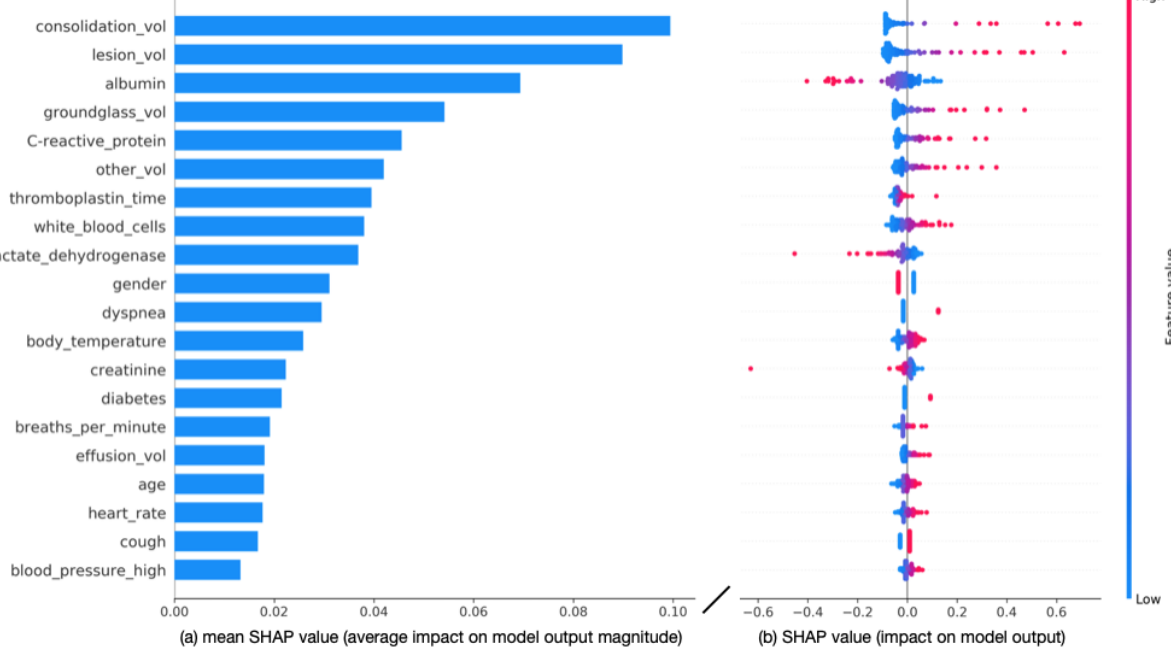
Figure 4. (A) Feature importance, evaluated using the mean SHAP (Shapely Addictive Explanations) values, in the logistic regression (LR) model using all features. (B) SHAP plot for the LR model using all features. Each point represents a feature instance, and the color indicates the feature value (red: high, blue: low). Negative SHA P values indicate feature instances contributing to a model output of a mild/ordinary COVID-19 case, whereas positive SHA P values indicate features contributing to a model output of a severe/critical COVID-19